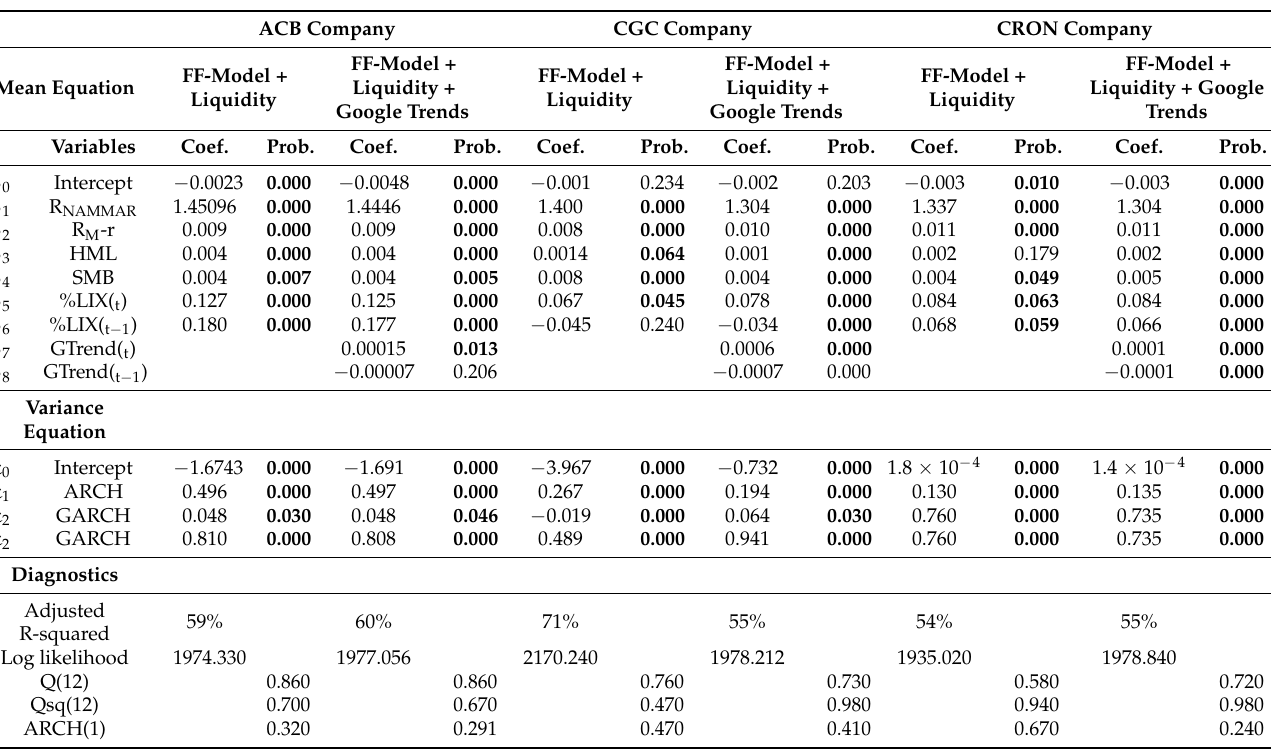
Table 2. Maximum likelihood estimations using asymmetric EGARCH(1,1)